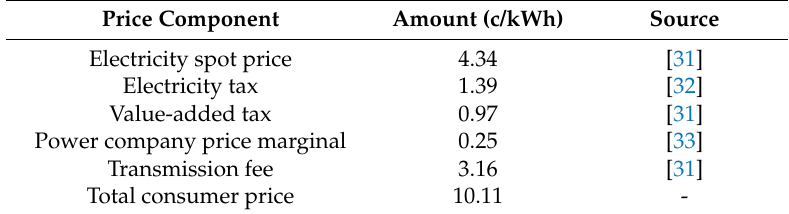
Table 1. The average makeup of the electricity price for consumers during the period studied